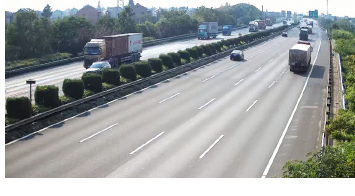
Figure 2. Real traffic